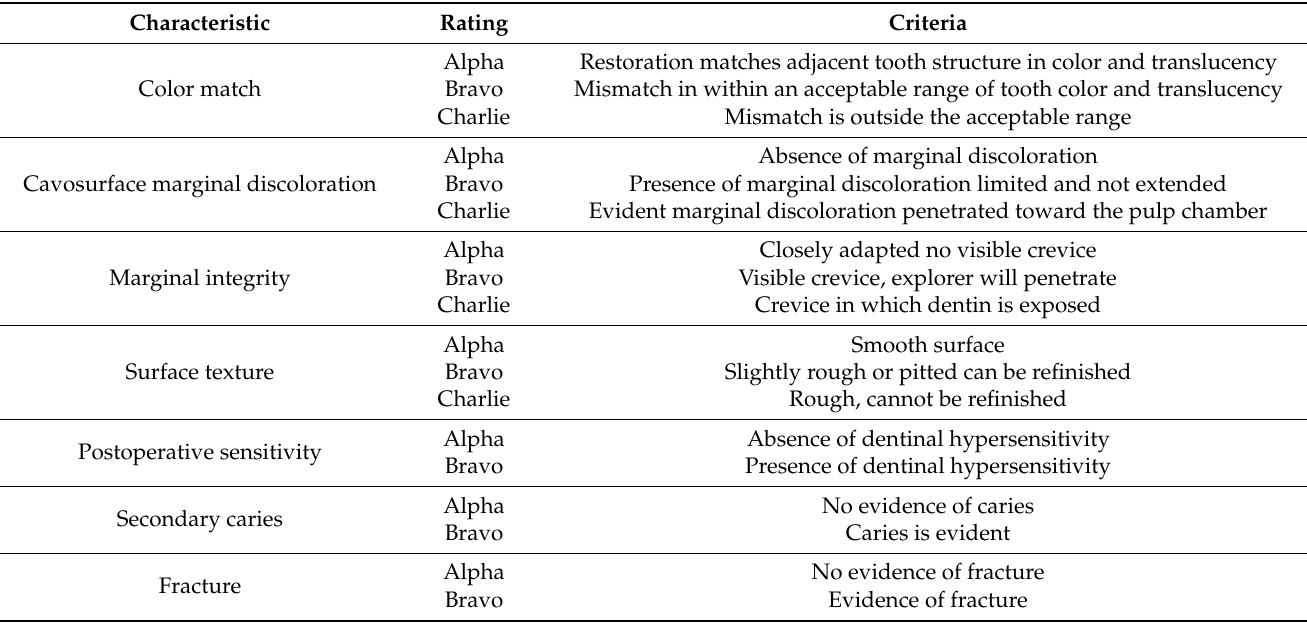
Table 1. The modified Ryge criteria used in the